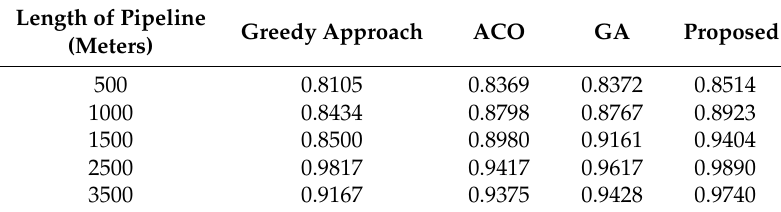
Table 9. Comparison of Normalized Life Time (Range 50 m).